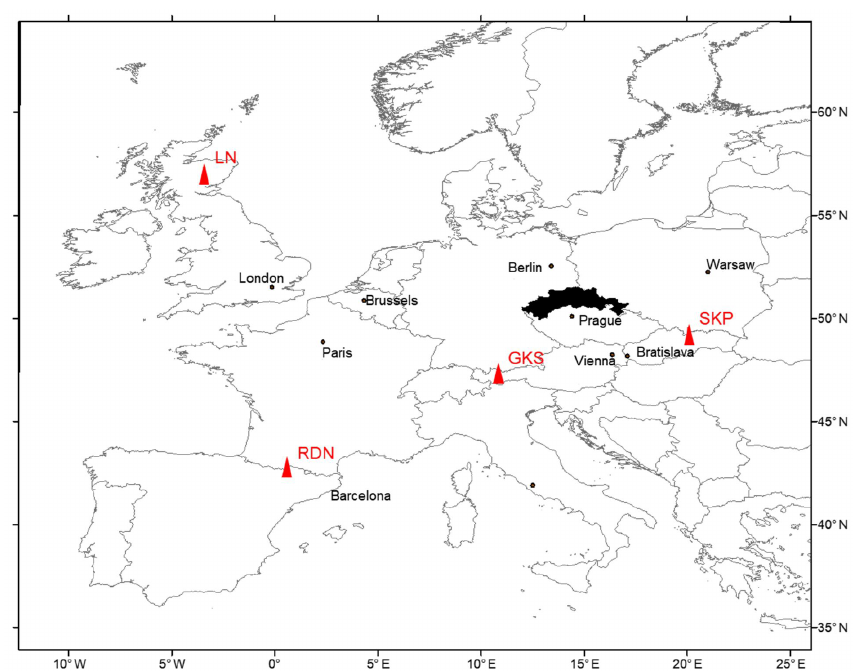
Figure 1. Location of the high-altitude areas included in this study. Lake identification: LN is Lochnagar, RDN is Lake Redon, GKS is Gossenköllesee and SKP is Skalnate Pleso. Situation of the Black Triangle between Germany, Poland and Czech Republic is indicated by a shaded